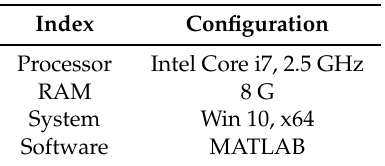
Table 1. Simulation configurations.